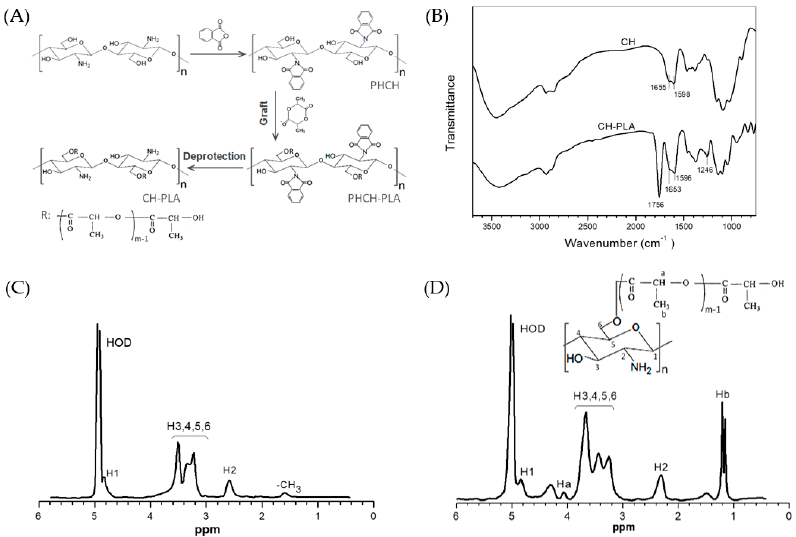
Figure 1. Schematic illustration ( A ) for synthesis of CH-PLA; FTIR spectra ( B ) of CH and CH-PLA; and 1 H NMR spectra of CH ( C ) and CH-PLA ( D ) (PLA content in CH-PLA: 40.7 wt %).